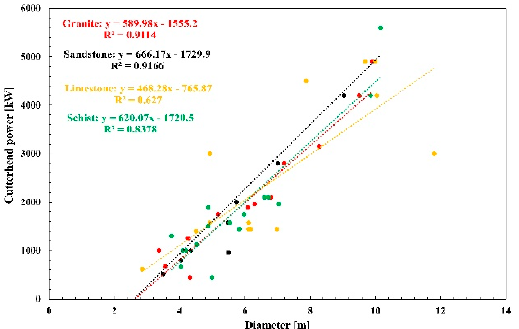
Figure 17. Correlation between the diameter and the power due to the excavation in granite, sand- stone, limestone, and schist by double shield TBMs.